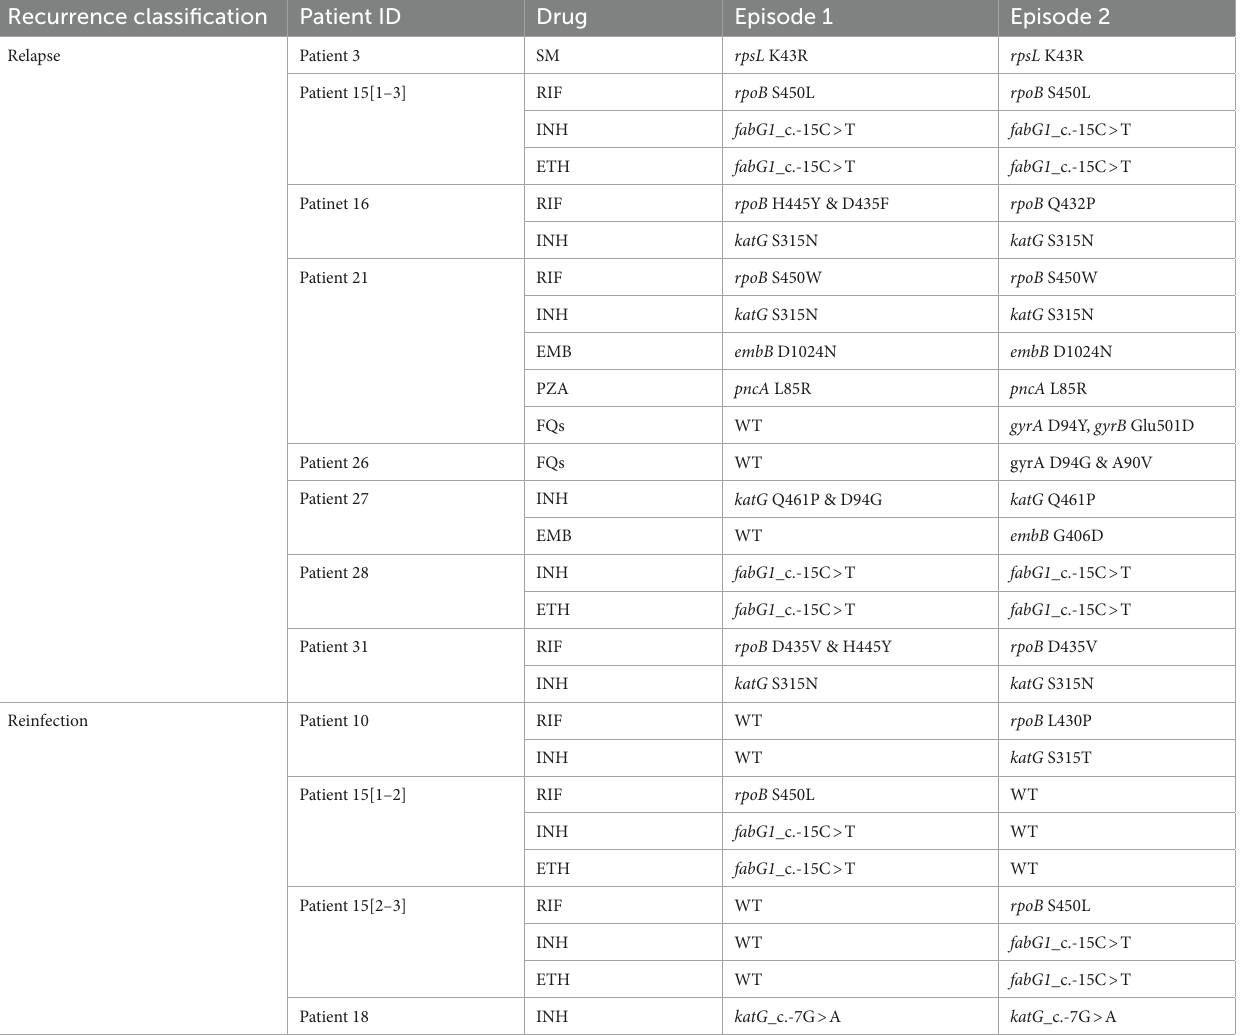
TABLE 1 Genetic mutations related to drug-resistance identified in the first and second episodes of recurrent TB